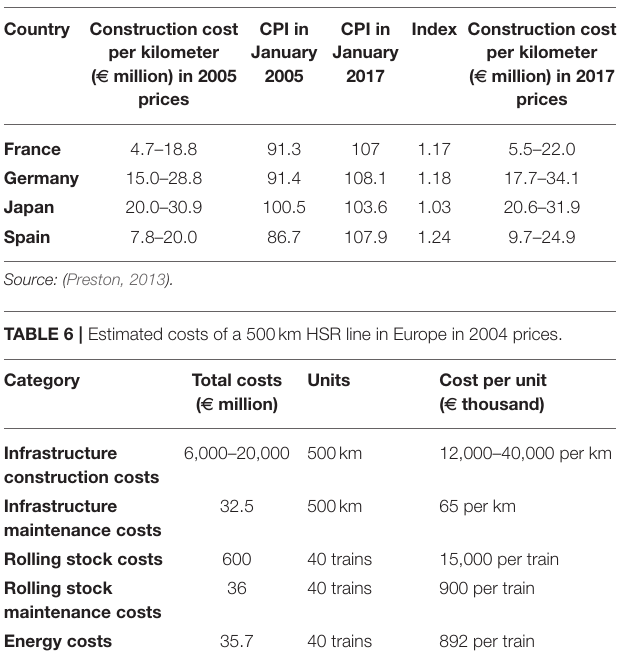
TABLE 5 | Construction Costs per route km of new high-speed lines.